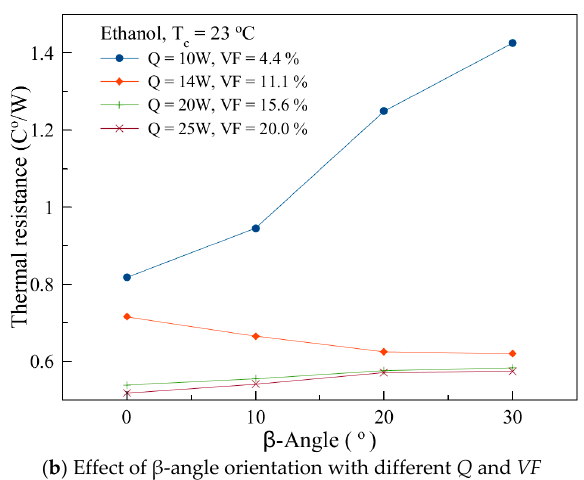
Figure 5. Effect of Orientation with different Q and VF .